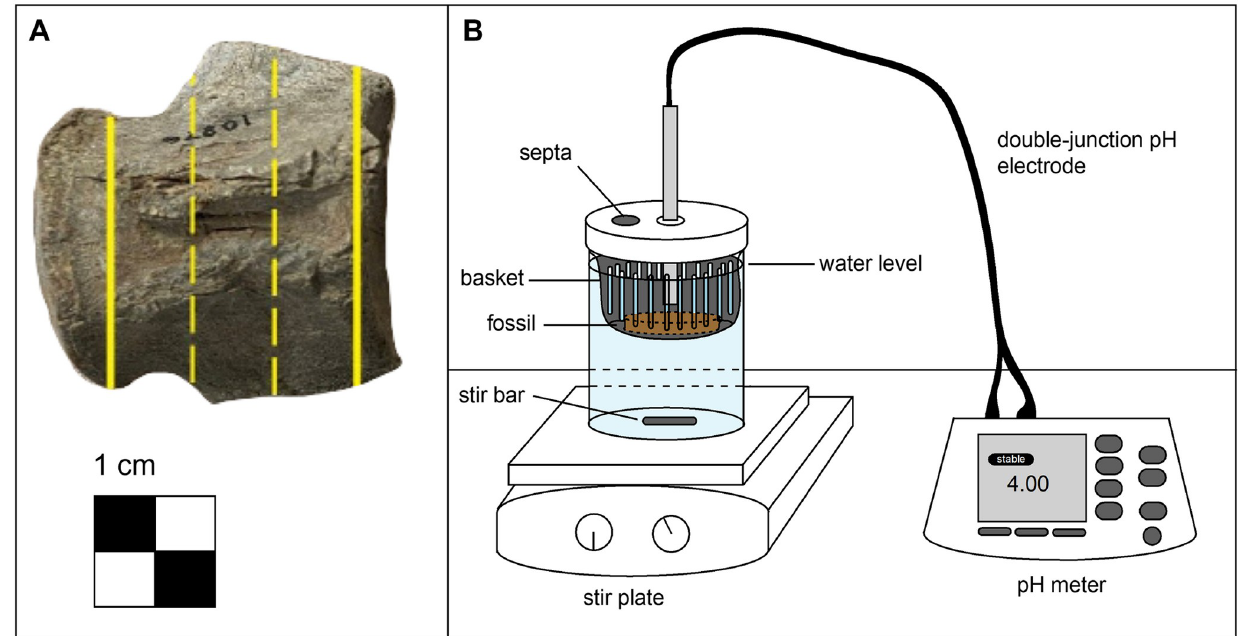
Fig 1. Fossil sectioning and experimental set up. (A) Depiction of the fossil sectioning process. The solid lines indicate cuts made to remove the end caps and dashed lines indicate cuts made to section the fossil into thirds. (B) Schematic of the dissolution experiment closed reaction vessel.